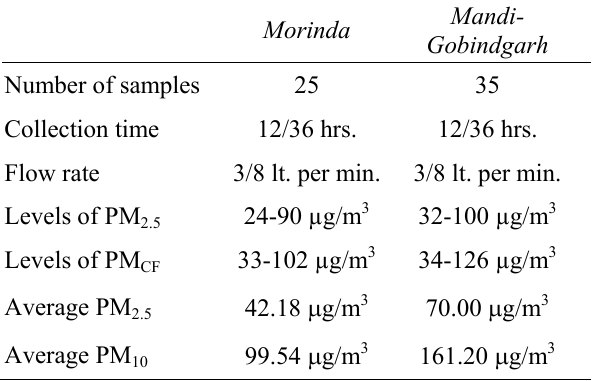
Table 2 : An overview of the sampling program, in the two study sites from August 1999 to May